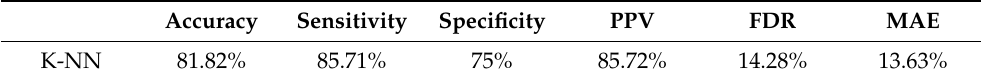
Table 6. Classification performance on the test set (30% of the total